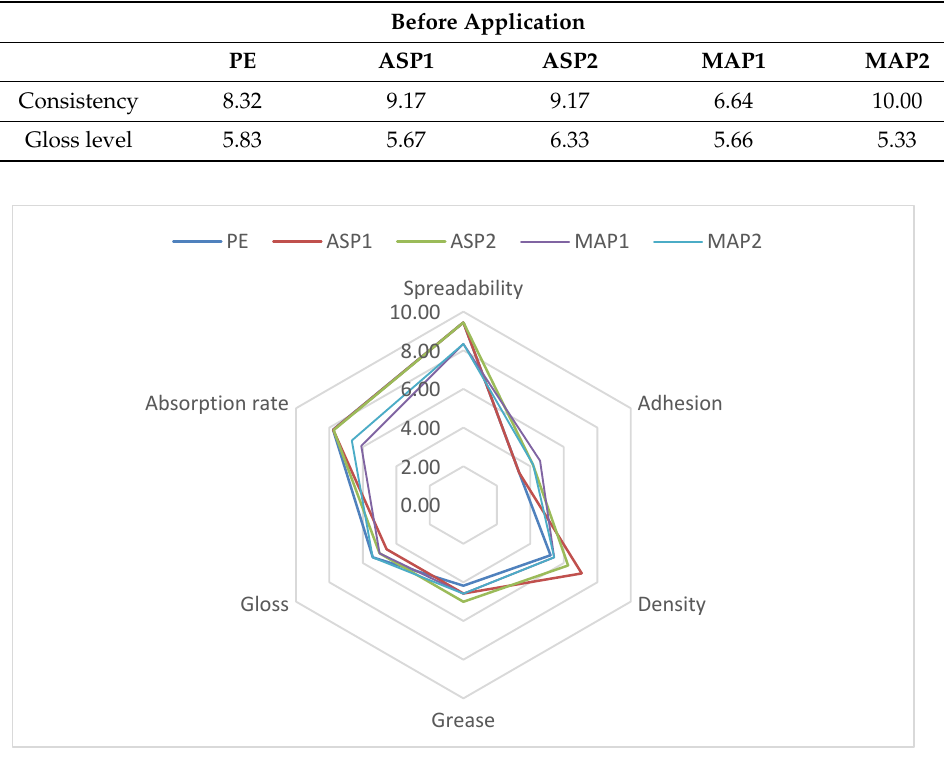
Figure 7. The results of the sensory analysis of the investigated samples during application.